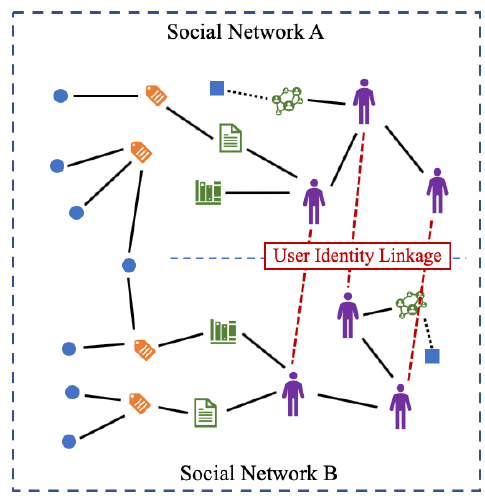
Figure 2. User identity linkage.